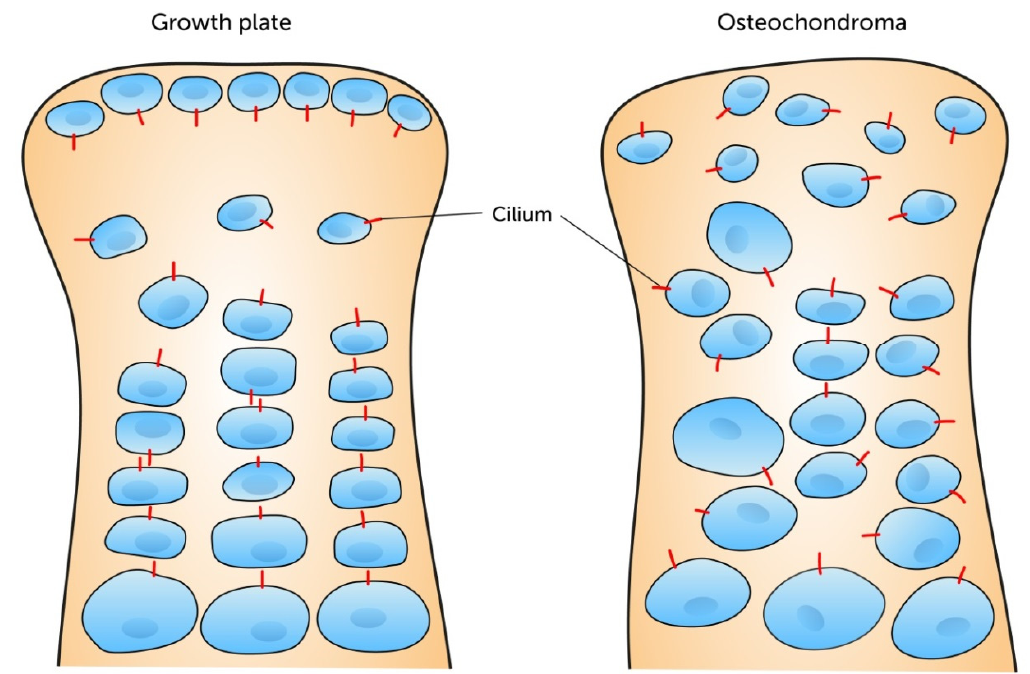
Figure 5. The ordered tissue morphology in healthy growth plates is accompanied by a certain pole-related ciliary orientation (chondrocytes given in blue, cilia given in red). In contrast, the disorganization of chondrocytes in osteochondromas is associated with a disordered ciliary alignment. Image modified from McGlashan et al. (2007)